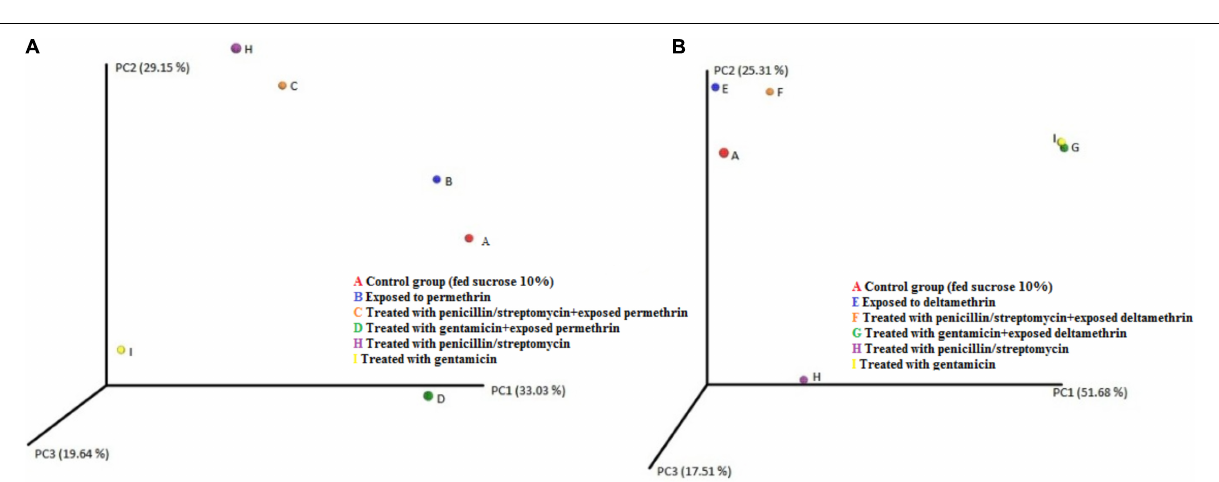
FIGURE 5 | PCoA plot using Bray–Curtis distance showing the distribution of bacterial community composition in A. aegypti. (A) permethrin exposure (B) deltamethrin